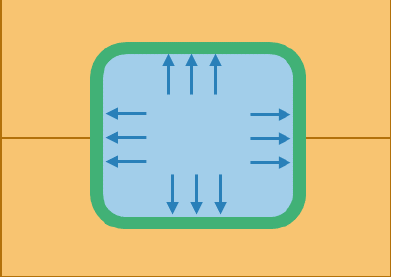
Figure 2. Cross section of trapped rubber processing (TRP).